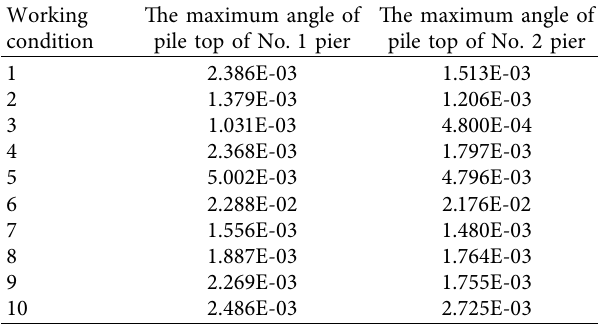
Figure 8: Sample time-history curves of the vessel collision force. (a) Under working condition 1. (b) Under working condition 2. (c) Under working condition 9. (d) Under working condition 10. Table 5: Maximum rotation angle of plastic hinge zone at top of pile foundation.